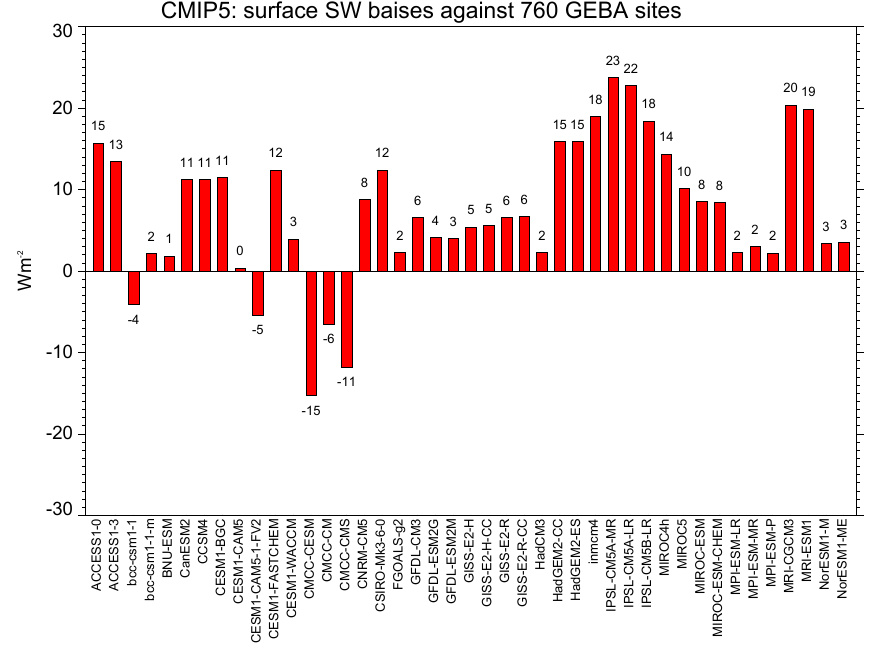
Figure 7. Average biases (model – GEBA observations) in surface downward shortwave radiation (Wm − 2 ) at Earth’s surface calculated in 43 different CMIP5 climate models averaged over 760 sites from GEBA. Adapted from Wild et al., 2015.